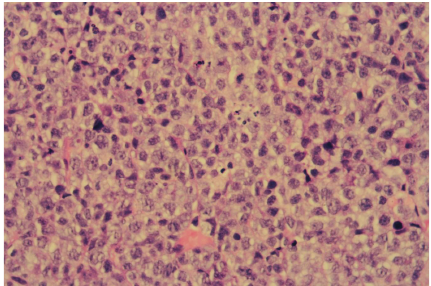
Figure 6: H&E stain showing large atypical lymphoid cells with apoptotic debris and mitotic figures (high power magnification).